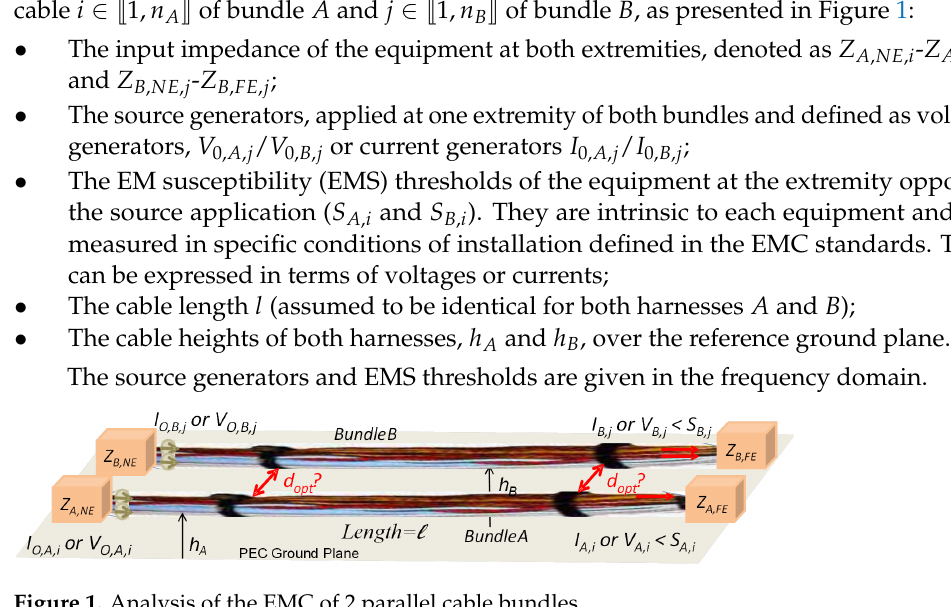
Figure 1. Analysis of the EMC of 2 parallel cable